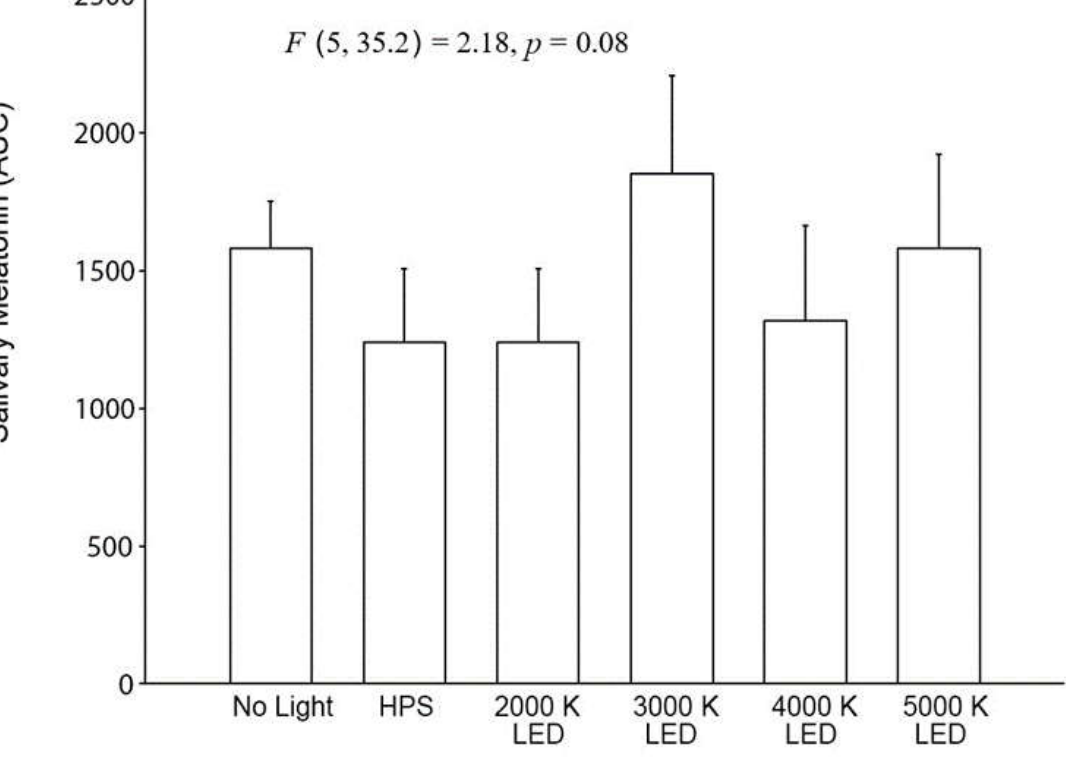
Figure 12. The bars shown above represent the AUC mean salivary melatonin levels (+SEM) for each of the six experimental conditions in the light trespass study. The integrated melatonin AUC values were calculated from the salivary melatonin values shown in Figure 11 for the exposure period only (12:00 A.M.–2:00 A.M.). The statistics are based on the LMM.